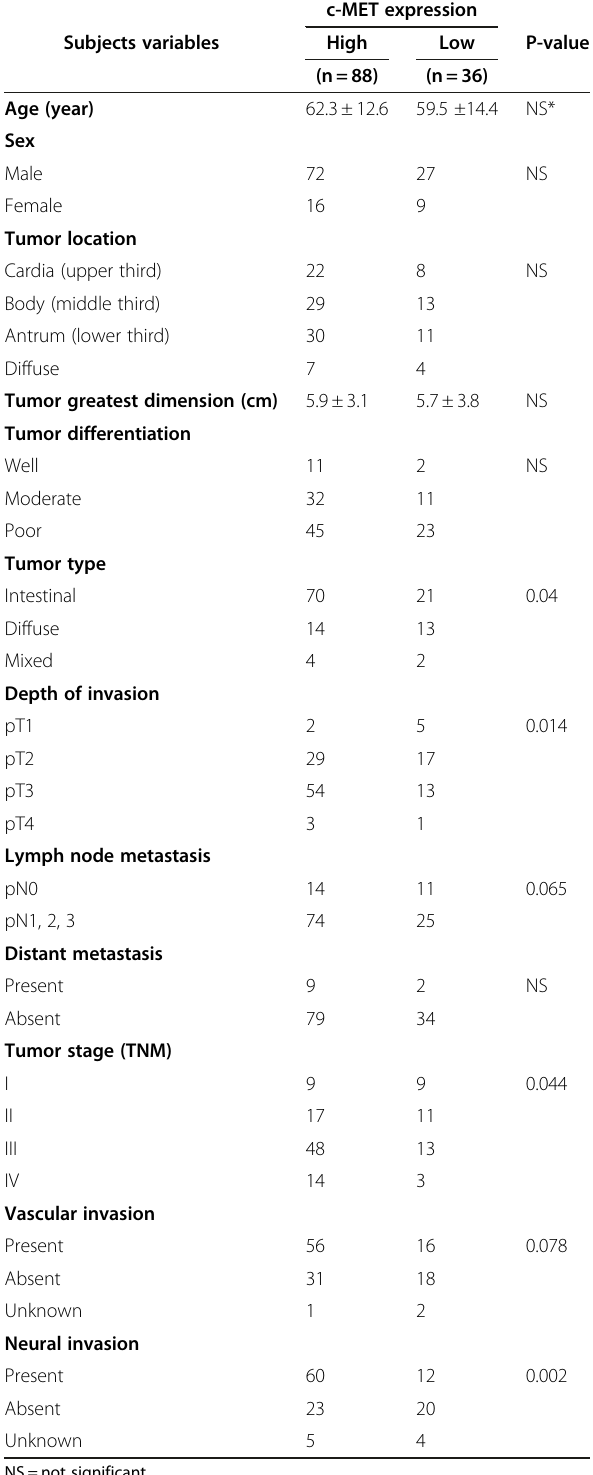
Table 1 Relationship between clinicopathological features and c-MET expression in gastric cancers (n